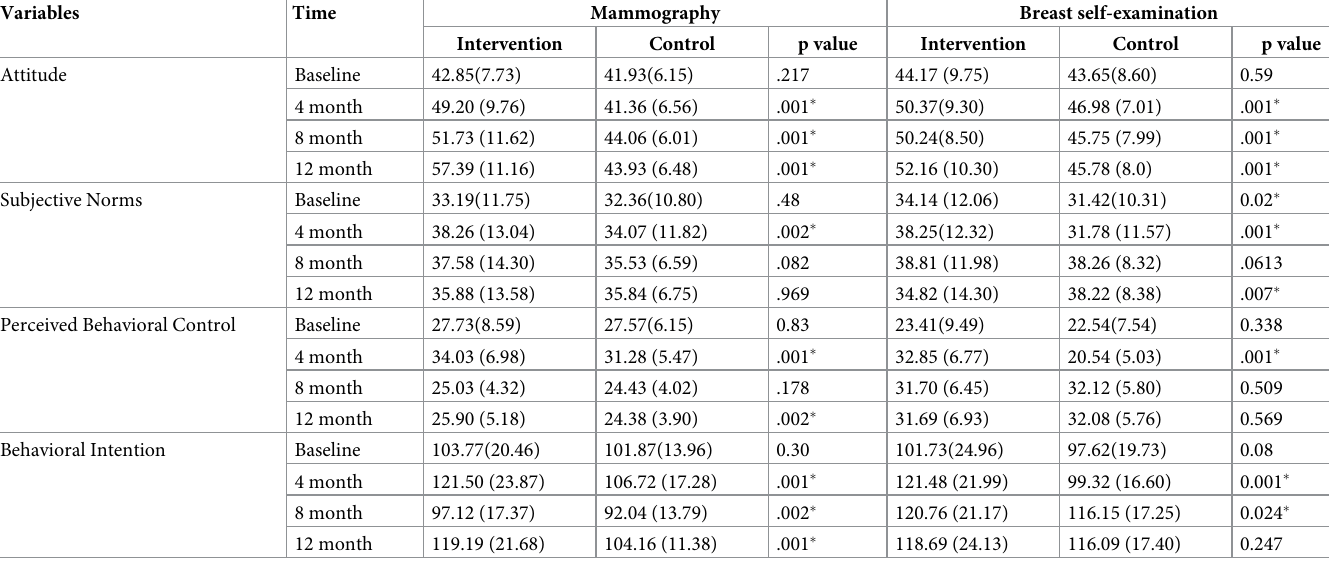
Table 5. Comparison of mean scores of TPB constructs in mammography and breast-self-examination at different end-points (n = 360).